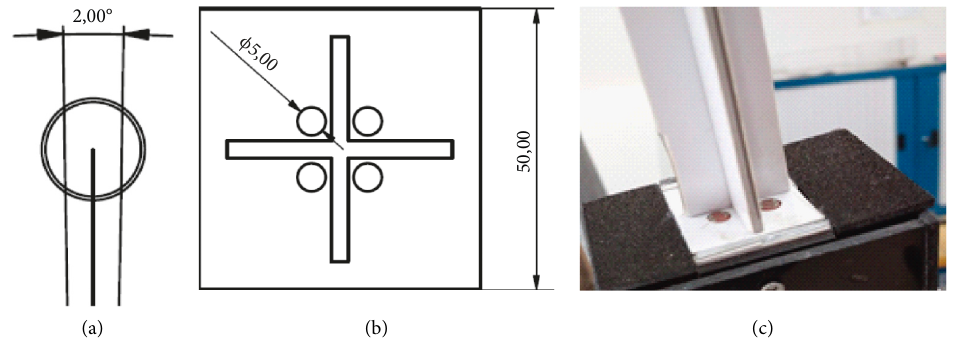
Figure 4: Solar positioning sensor: (a) tracking error, (b) top view of the sensor, and (c) positioning sensor.